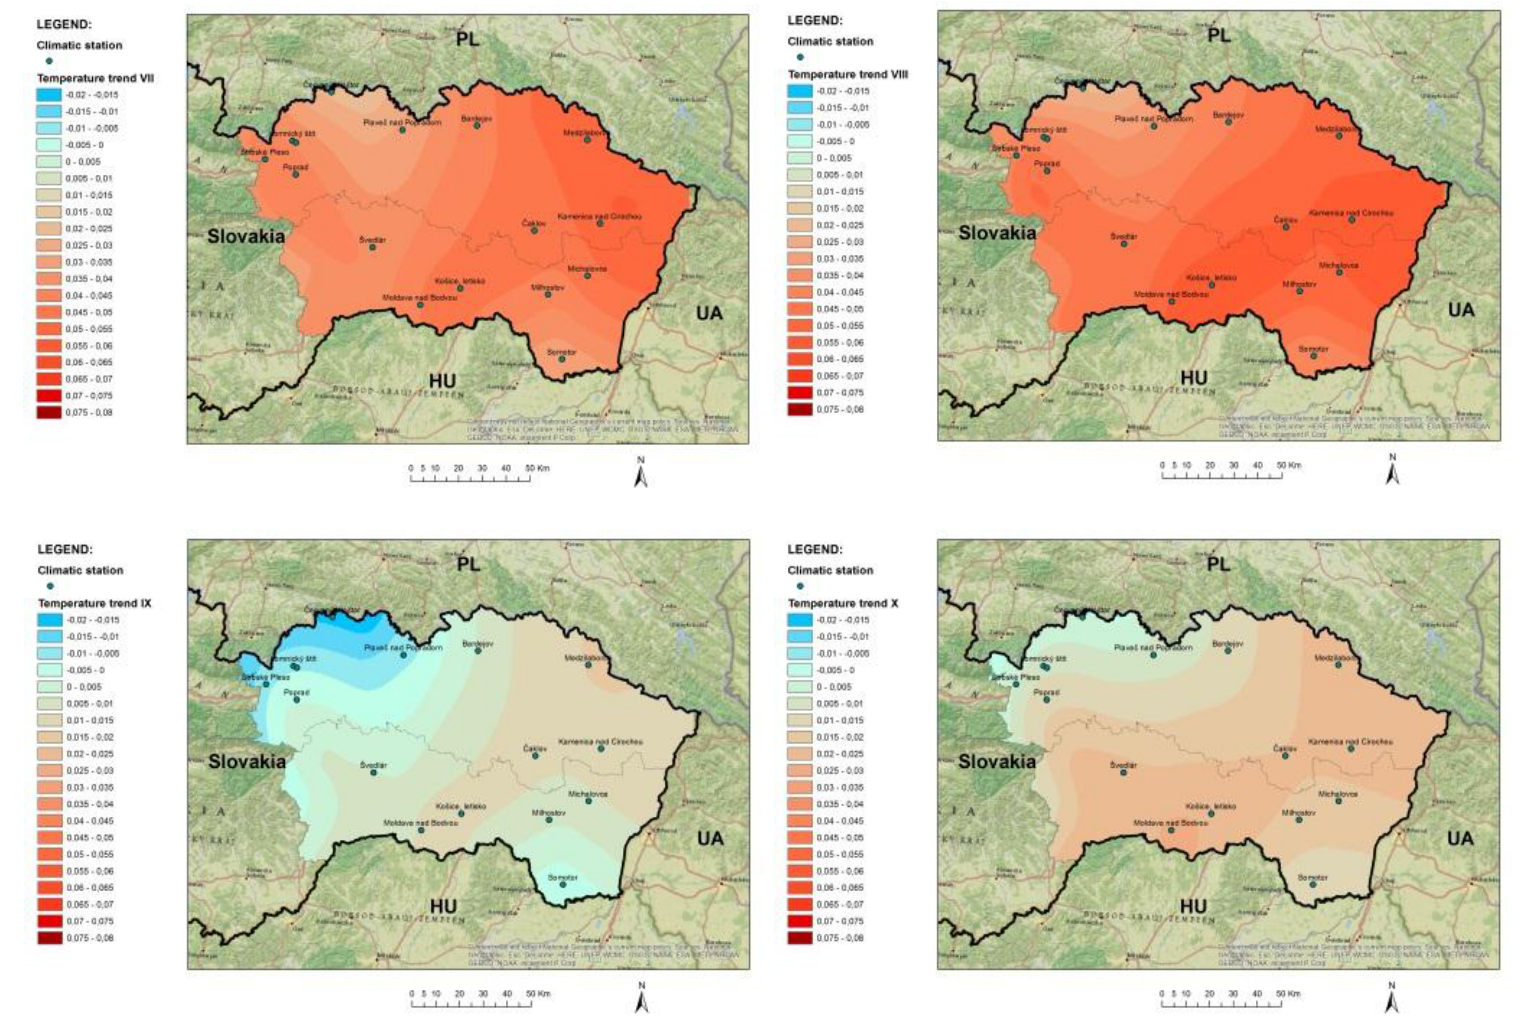
Figure 6. Spatial distribution of temperature trends.